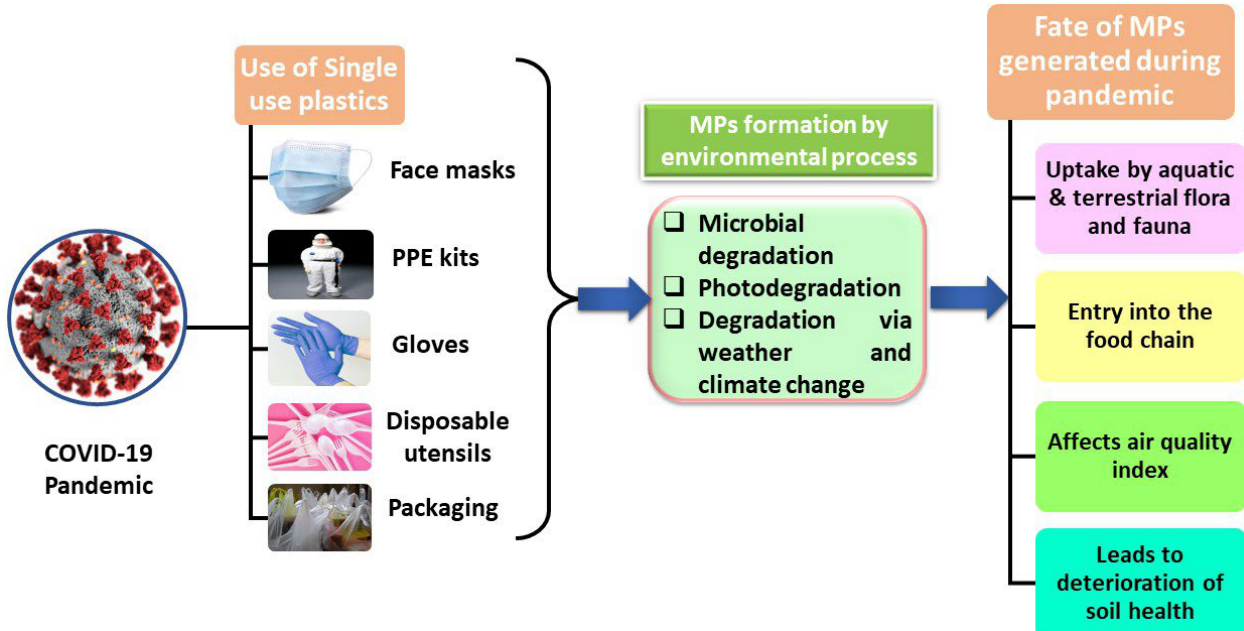
Figure 3. Sources, environmental processing, and fate of MPs generated during COVID-19.